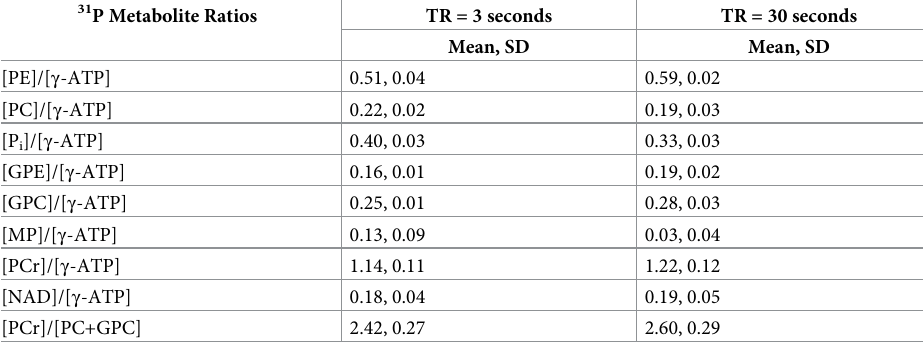
Table 1. 31 P metabolite concentration ratios determined at 7 Tesla (n = 6).